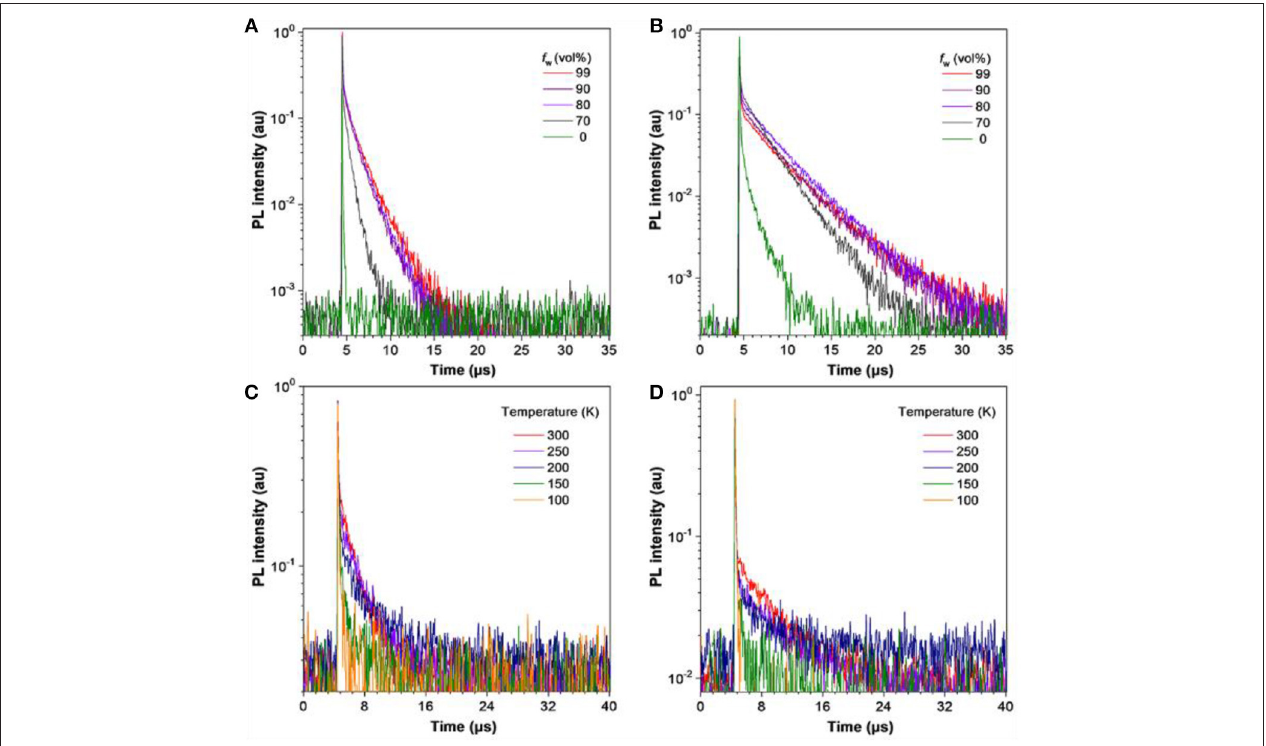
FIGURE 4 | Transient PL decay spectra of (A) TRZ-HPB-PXZ and (B) TRZ-HPB-DMAC in THF/water mixtures with different water fractions ( f w ). Temperature dependent PL transient decay spectra of neat films of (C) TRZ-HPB-PXZ, and (D) TRZ-HPB-DMAC, measured under